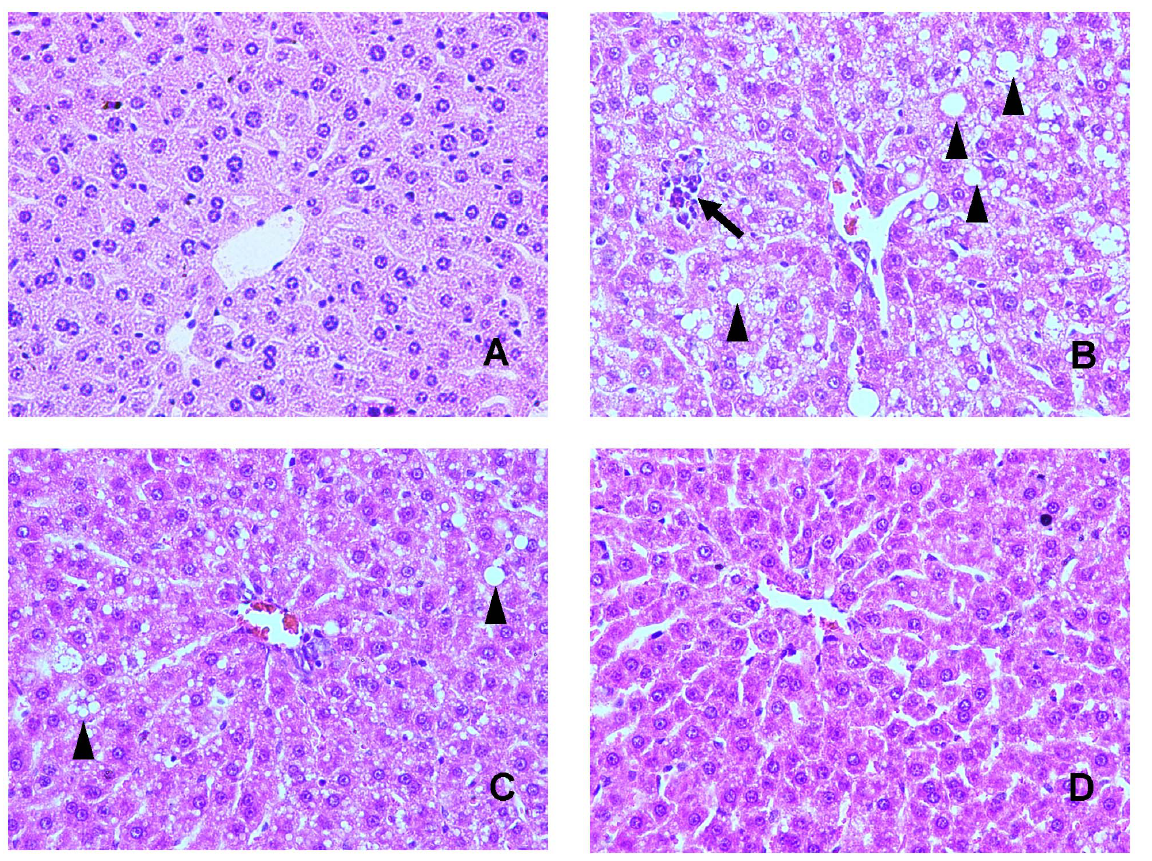
Figure 3. Effects of nuciferine on liver histology. (A) Liver sections from hamsters fed the normal diet showed normal liver histology. (B) In HFD fed hamsters, numerous macrovesicular fat droplets (arrow head) and mild necroinflammatory foci (arrows) were present. (C) and (D) Treatment with nuciferine (10 and 15 mg/kg ? BW/day) for 8 weeks resulted in prevention of hepatic fatty deposition in hepatocytes and infiltration of the inflammatory cells in the hepatic parenchyma. The tissues were surgically excised and subjected to histological study by staining with hematoxylin and eosin. All the magnification is 200 6 . fatty acid synthase (FAS), stearoyl-CoA desaturase 1 (SCD-1), and acyl-CoA:diacylglycerol acyltransferase 2 (DGAT-2). The results